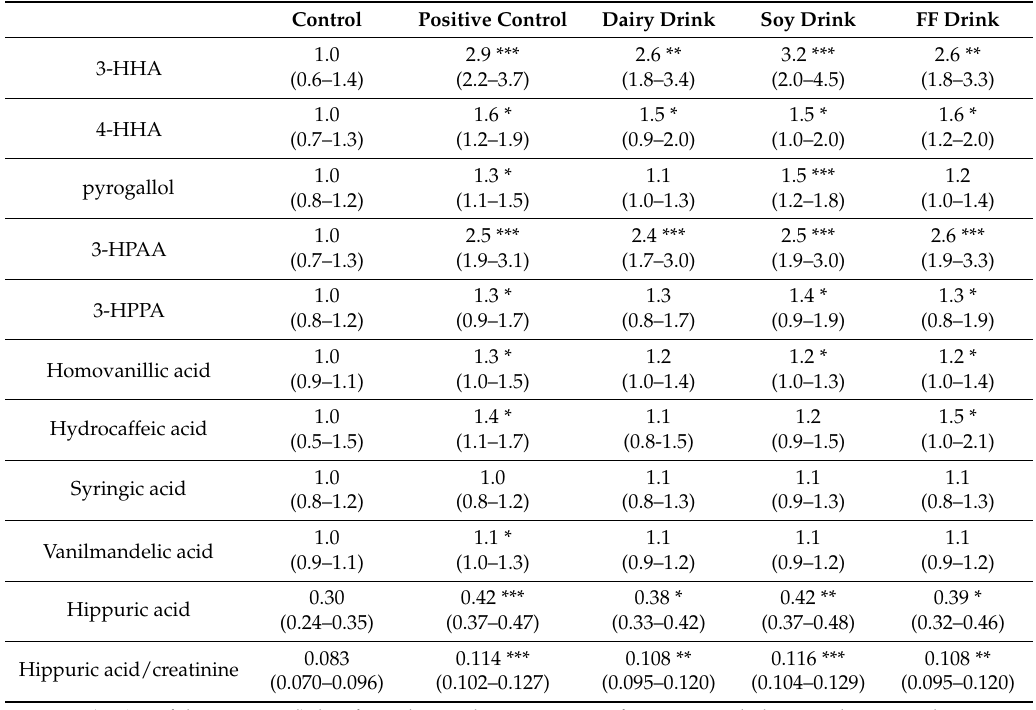
Table 3. Relative 24-h cumulative urinary excretion of phenolic metabolites after consumption of different test products with control as the reference